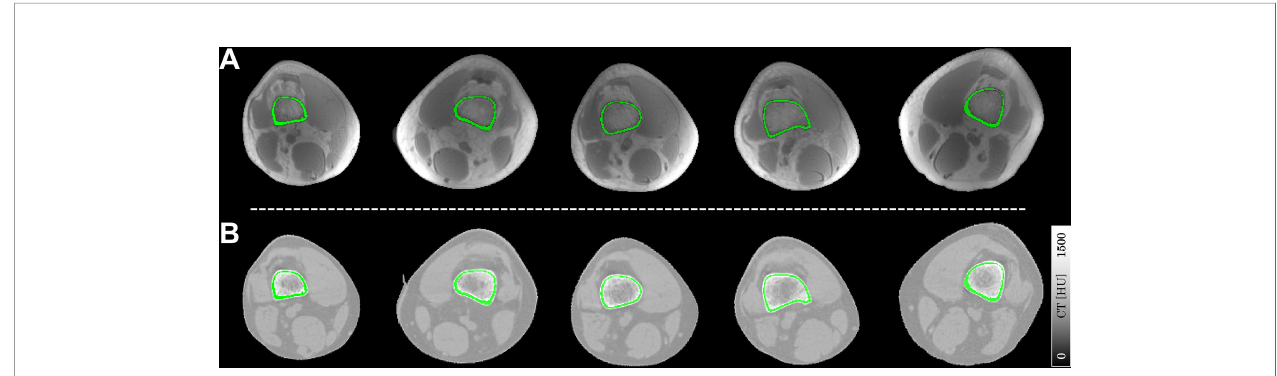
FIGURE 1 | Representative slices of ROIs of cortical bone (in green) overlaid on the UTE magnitude images (A) and registered CT images (B) . Each column represents a typical ROI from an individual subject in this